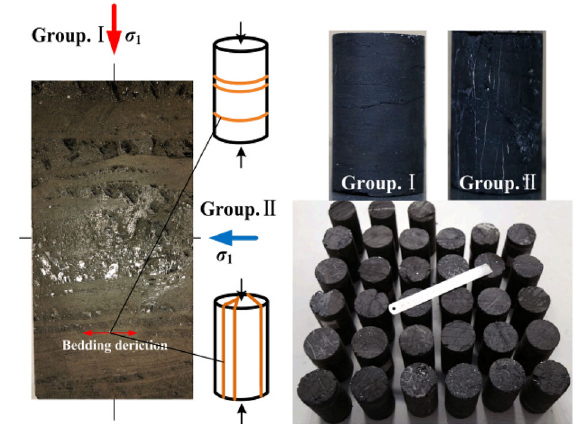
Fig. 1 Location map of sample Xiaoqing mine of the Tiefa Coal Group Fig. 2 Coal